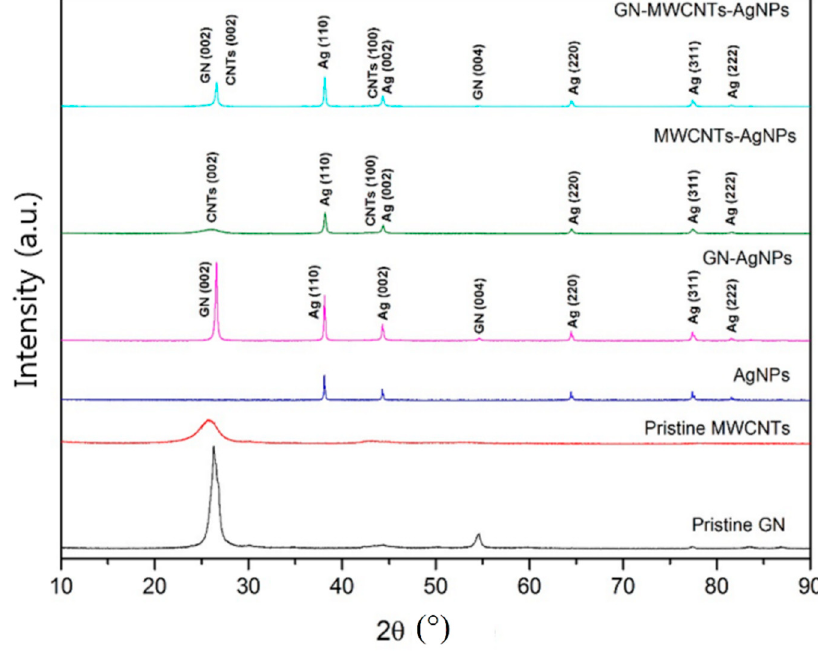
Figure 5. XRD patterns of pristine GN, MWCNT, AgNPs and their hybrids.